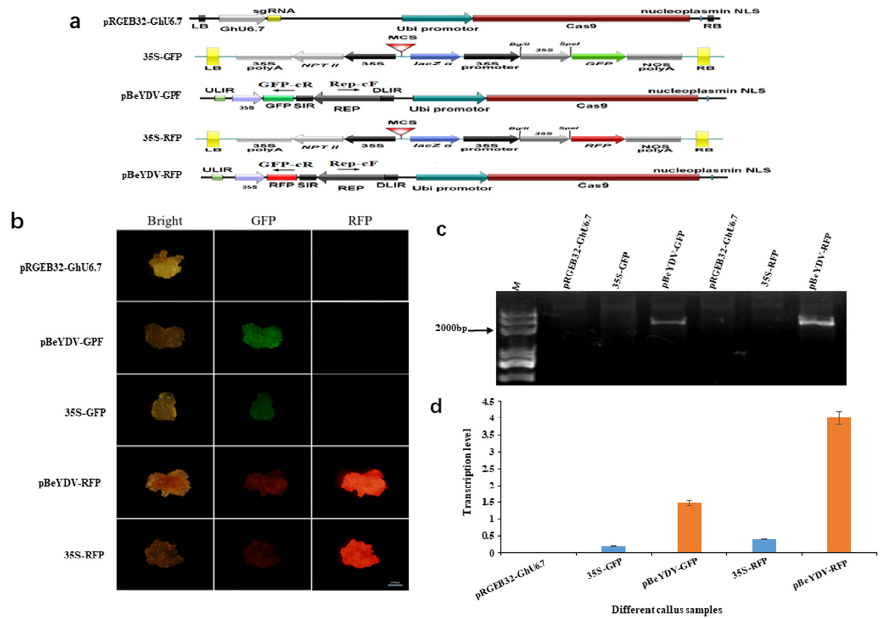
Figure 1. The analysis of GFP/RFP activity within the BeYDV. ( a ) The schematic diagram of pBeYDV-GFP/RFP and 35S-GFP/RFP vectors in cotton. RB and LB are Agrobacterium right and left borders. ULIR, DULIR: large intergenic region; SIR: small intergenic region; Rep: replication protein. ( b ) GFP and RFP expression in cotton callus with different vectors. The cotton callus targeting to GFP and RFP fluorescence. The fluorescence of callus transformed with pBeYDV-GFP and pBeYDV-RFP vectors was significantly stronger than 35S-GFP and 35S-RFP vectors. pRGEB32- GhU6.7: The control. Bar = 0.5 cm. ( c ) Detection of cyclized structure of BeYDV in cotton callus. The DNA samples transformed with pBeYDV-GFP and pBeYDV-RFP vectors can amplify a band with the size of 2.1 kb using specific primers (Rep-cF and GFP/RFP-cR). ( d ) The relative expression of GFP and RFP in pRGEB32-GhU6.7, 35S-GFP, 35S-RFP, pBeYDV-GFP, and pBeYDV-RFP cotton cal- lus. ** Means the difference is significant at the 0.01 level.